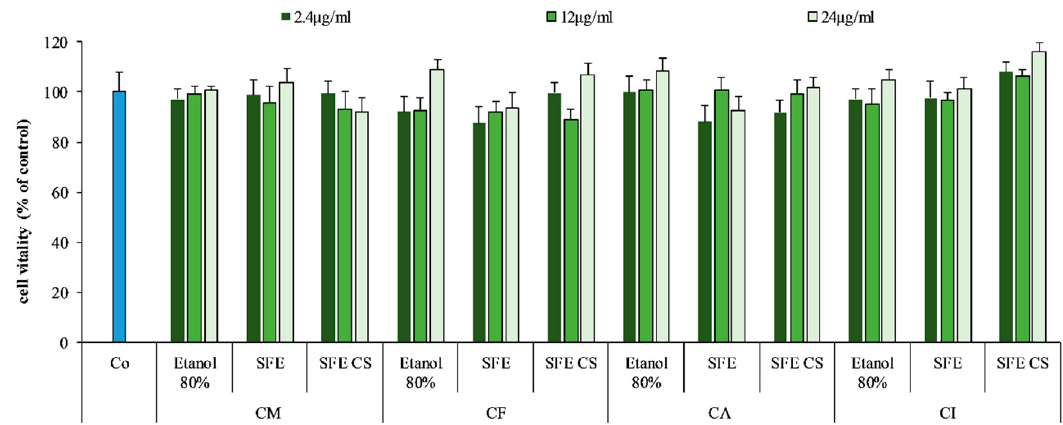
Figure 5. Percentage of vitality of HS68 fibroblast cells, determined by MTT (each data is presented as mean ± SD; n = 12). Cells treated with different extracts of Calendula (ethanol 80%, SFE and SFE CS) for 24 h to concentrations 2.4, 12, and 24 µg/mL (0.1% < ethanol). Co = control (no treatment); CM: C. maritima ; CF: C. su ff ruticosa subsp. fulgida ; CI: C. hybrid ( maritima × fulgida ); CA: C. arvensis.